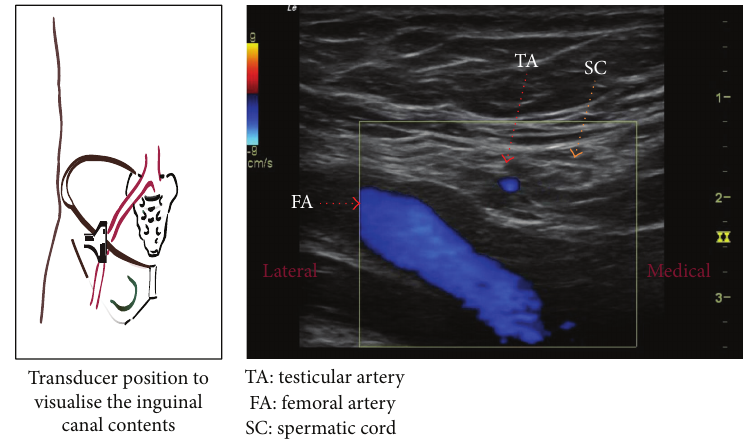
Figure 2: Visualization of structures in the inguinal canal and transducer orientation.